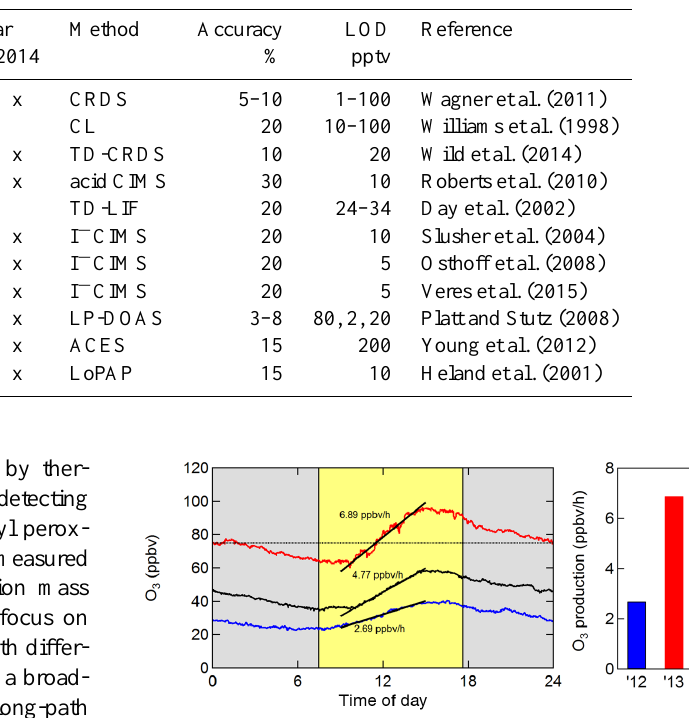
Figure 2. Diel averages of ozone mixing ratios during the cam- paigns in 2012 (45 days), 2013 (28 days), and 2014 (27 days), and the 75ppbv NAAQS for reference. Average ozone levels were 2.5 times higher in 2013 than 2012. Linear fits to the midday ozone in- crease illustrate the difference in average daily ozone production, plotted on the